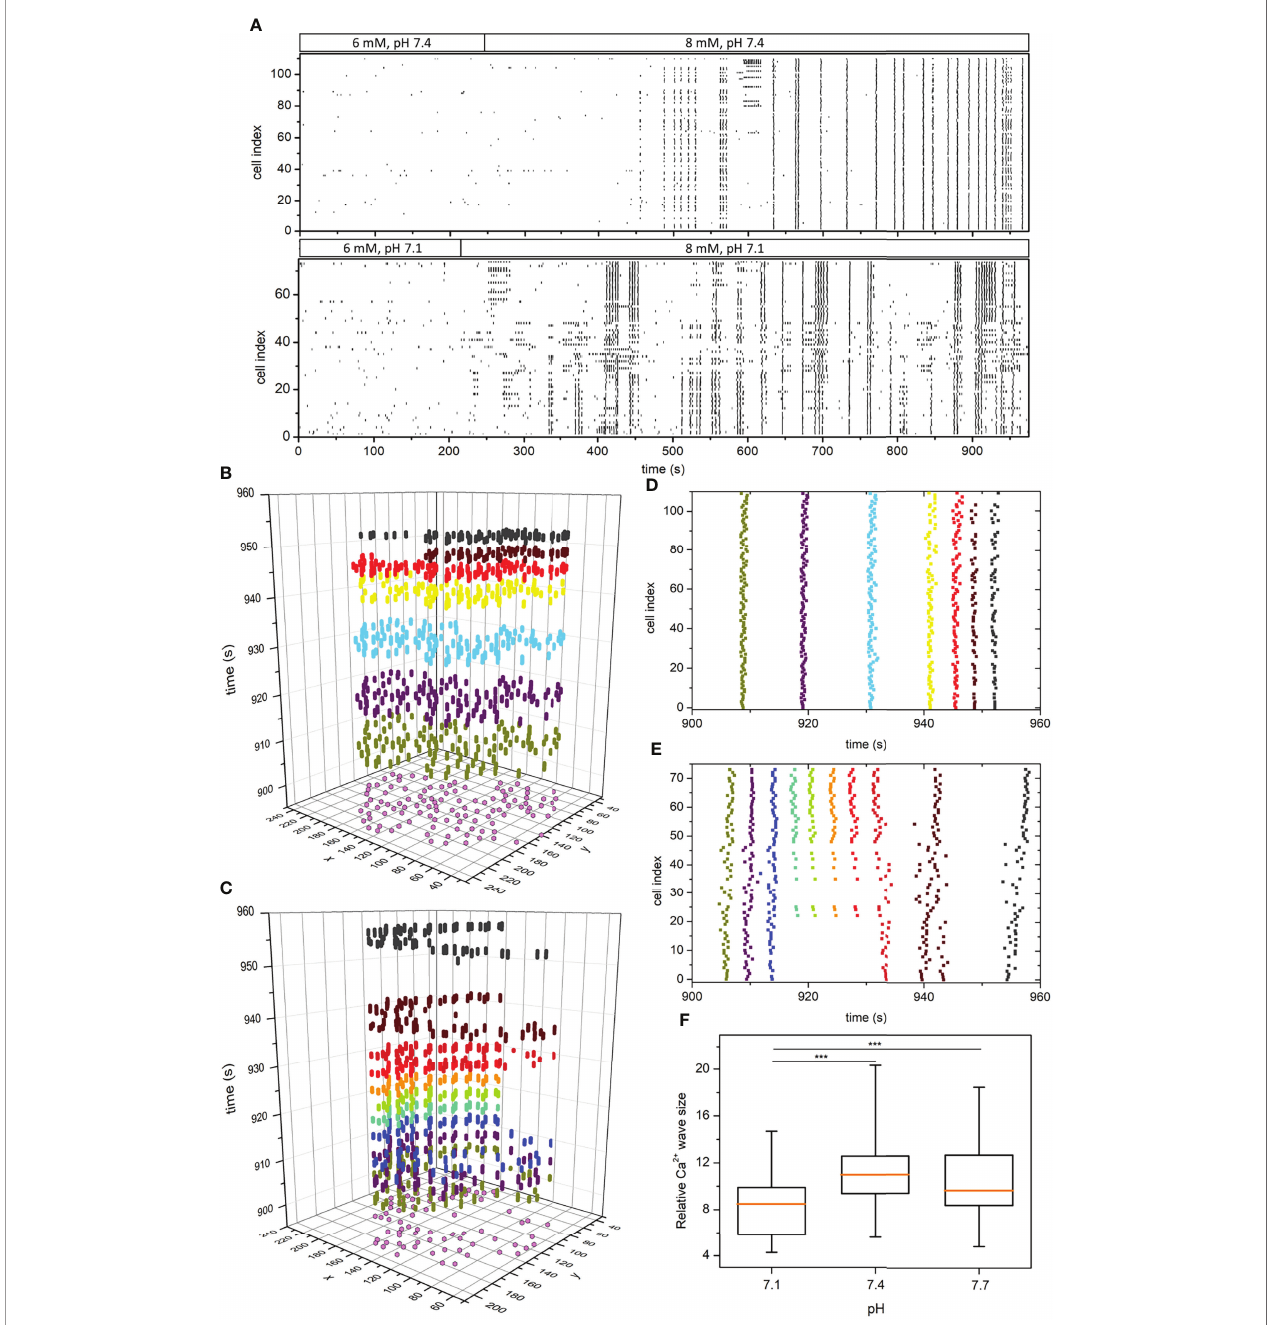
FIGURE 4 | pH-dependent spatiotemporal organization of intercellular Ca 2+ waves in islets. Raster plots of binarized fast [Ca 2+ ] c oscillations of all cells in two representative islets stimulated with 8 mM glucose under pH 7.4 and 7.1, as indicated by the protocol bars (A) . Space-time graphs (B, C) and the corresponding raster plot outtakes (D, E) in the plateau phase of sustained activity under 8 mM glucose and under pH 7.4 (B, D) and pH 7.1 (C, E) . The colors of dots in panels (B, C) signify different extracted Ca 2+ waves and purple dots in the x-y plane denote the coordinates of individual beta cells. The box-plots in panel (F) signify the distribution of relative Ca 2+ wave sizes under different pH pooled from 3 different islets for each pH level. Box plots are showing upper and lower quartile; line median; whiskers 5-95%. (***p <